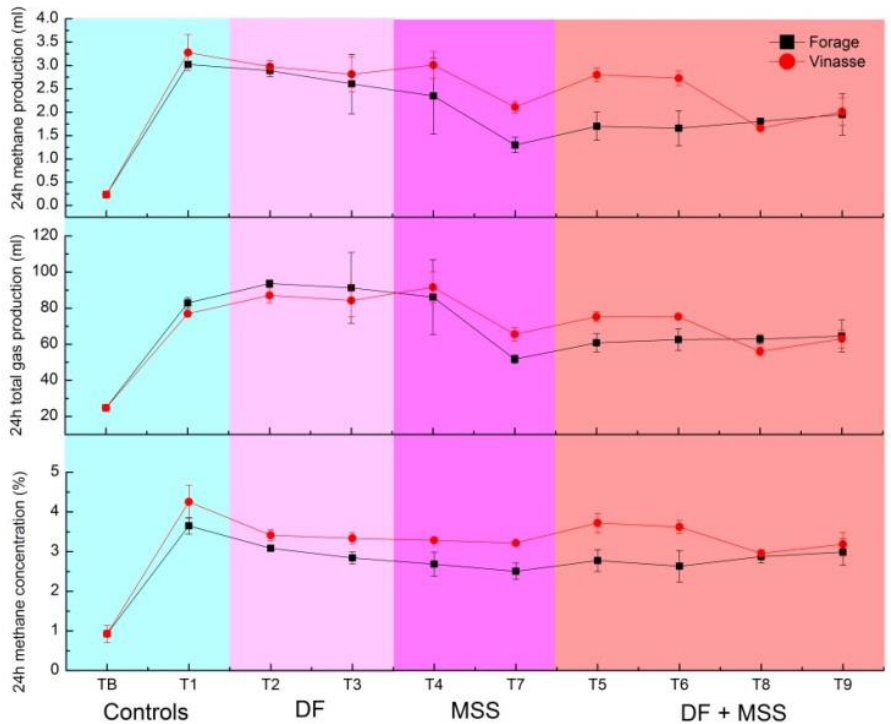
Figure 1. Effect of monensin sodium salt (MSS) and/or disodium fumarate (DF) supplementation on in vitro methanogenesis under different substrates (forage or vinasse). Inoculated bottles with a no-supplementation control (T1) and non-substrate control bottles (TB).